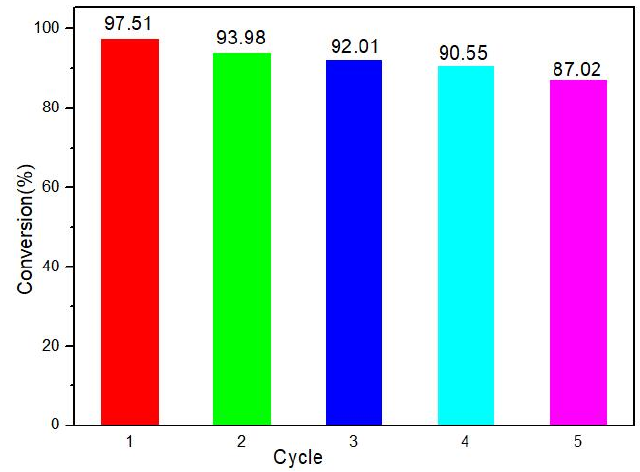
Figure 10. The results of stability test for the catalysts ZnPc.